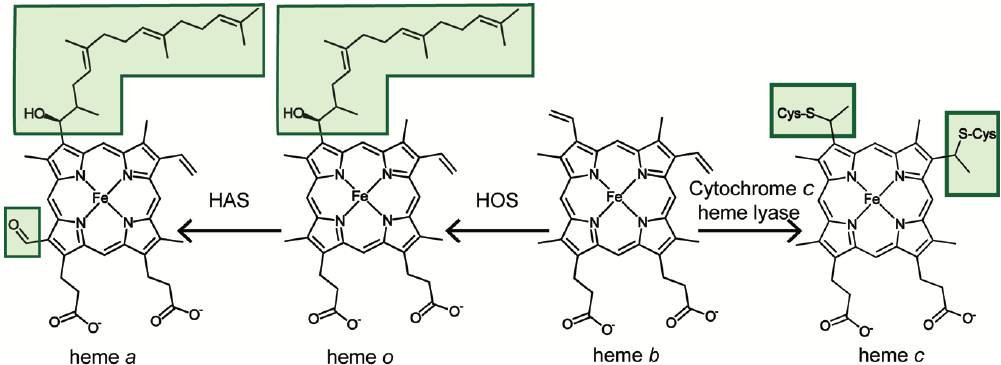
Figure 1. Chemical structures of the various heme types in eukaryotes. Starting with the heme b precursor (protoheme), heme c is made through covalent attachment to the sulfhydryl moieties of either cytochrome c or complex III subunit cytochrome c 1 ; this process is assisted by the cytochrome c lyases. Heme a is synthesized from heme b through the sequential action of heme o synthase and heme a synthase enzymes, going through the intermediate, heme o .